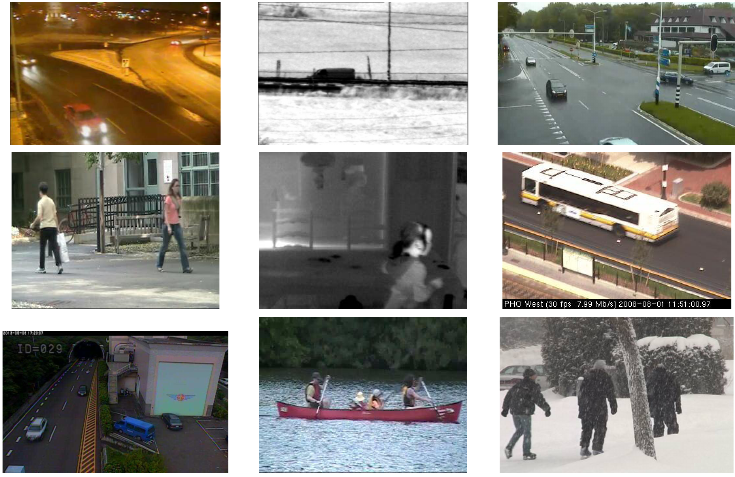
Figure 4. Example scenes in the CDnet 2014